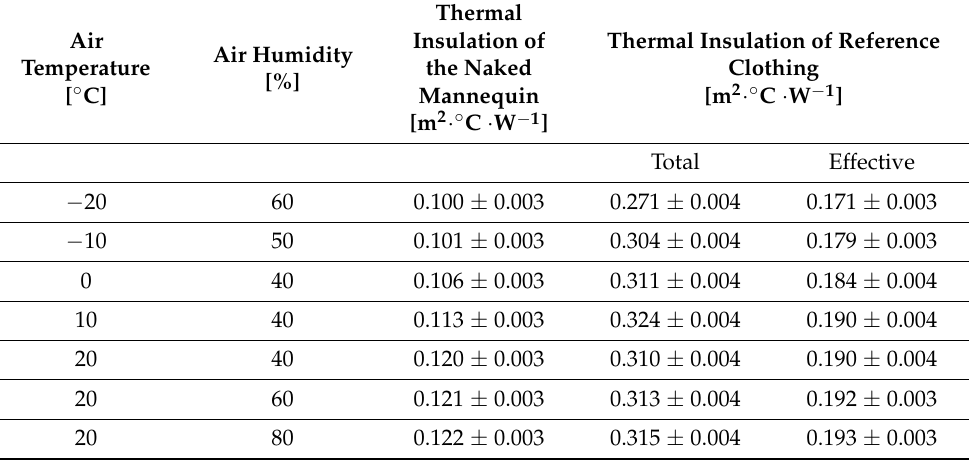
Table 5. Total thermal insulation of the naked mannequin and the reference clothing under different environmental